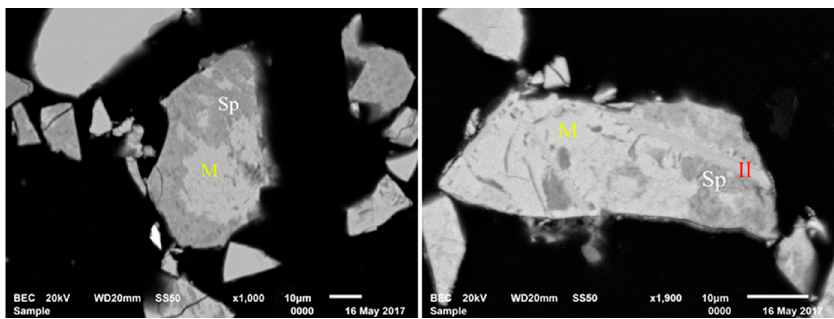
Figure 7. SEM images of the vanadium-titanium magnetite concentrate.